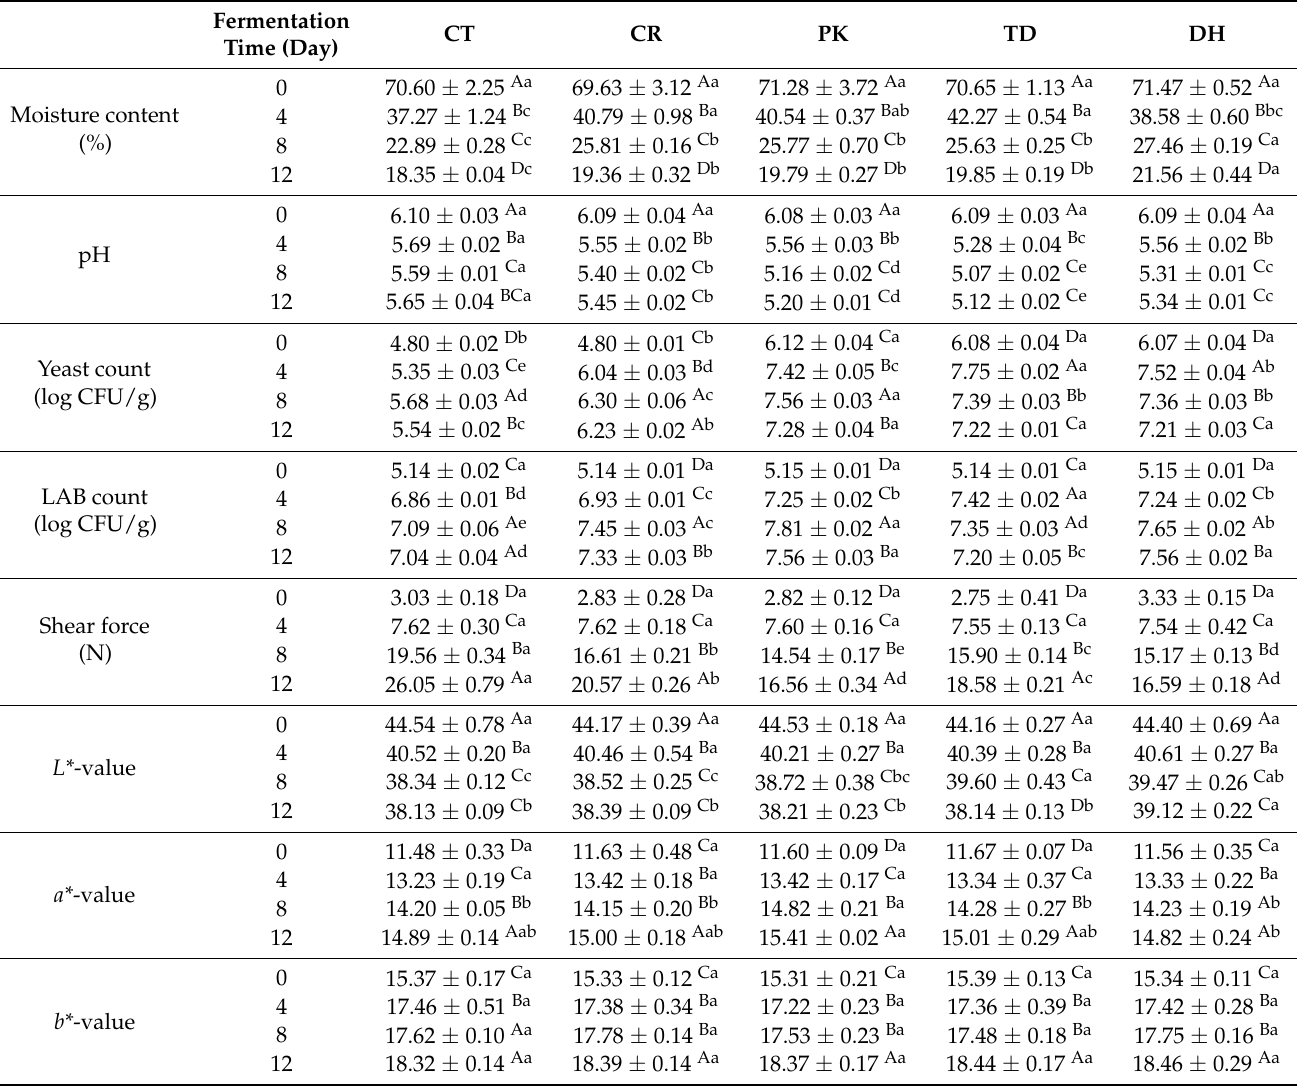
Table 3. Changes in physical, microbial, and quality characteristics of the control and reduced-salt dry sausages with and without inoculation of different yeast strains during a 12-day fermentation